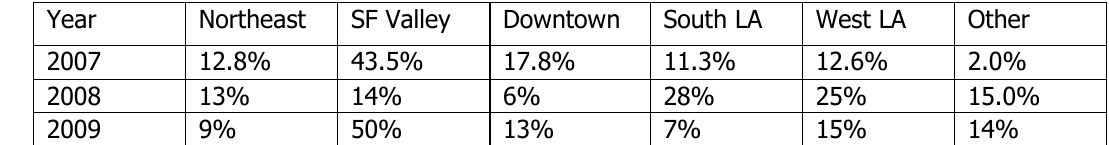
Geographic representation of youth participants/attendees at the